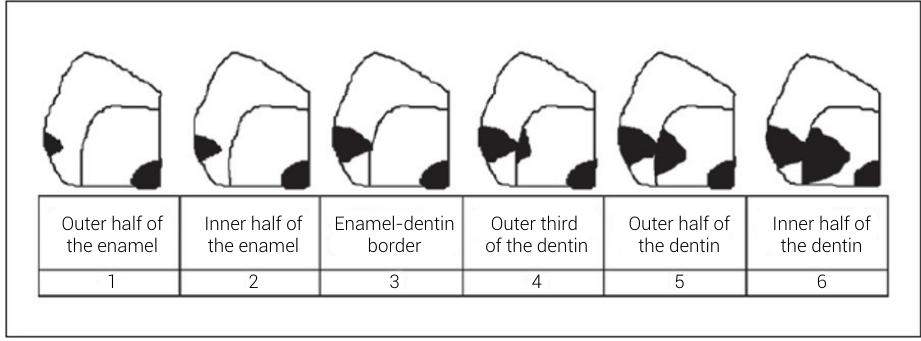
Figure 2. an illustration of the radiographic stages of approximal carious lesions 17